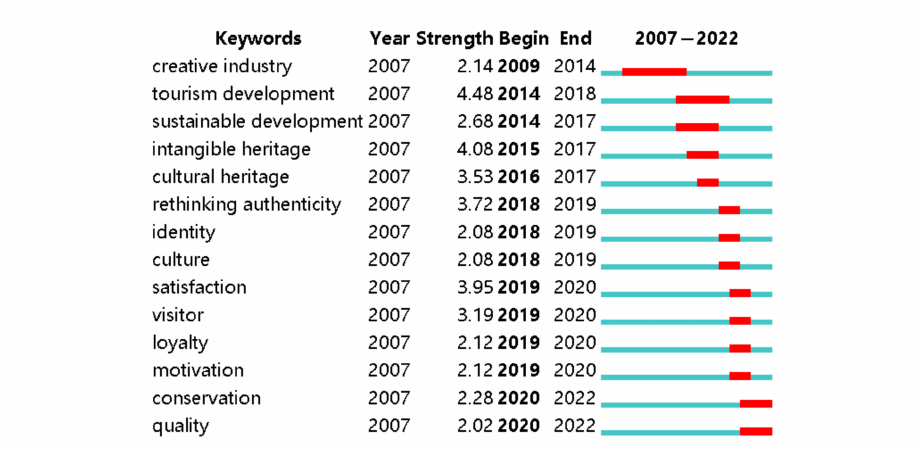
Figure 6. Keyword burst in foreign